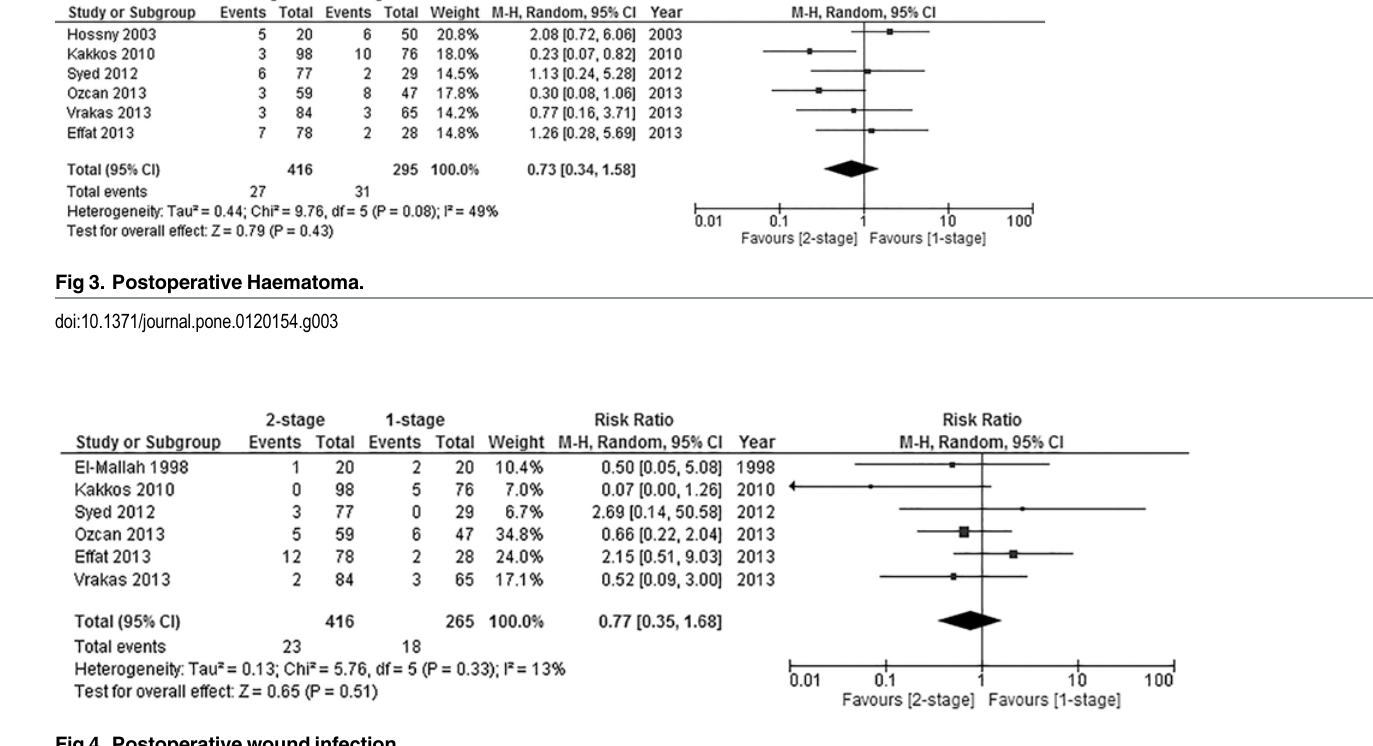
Fig 4. Postoperative wound